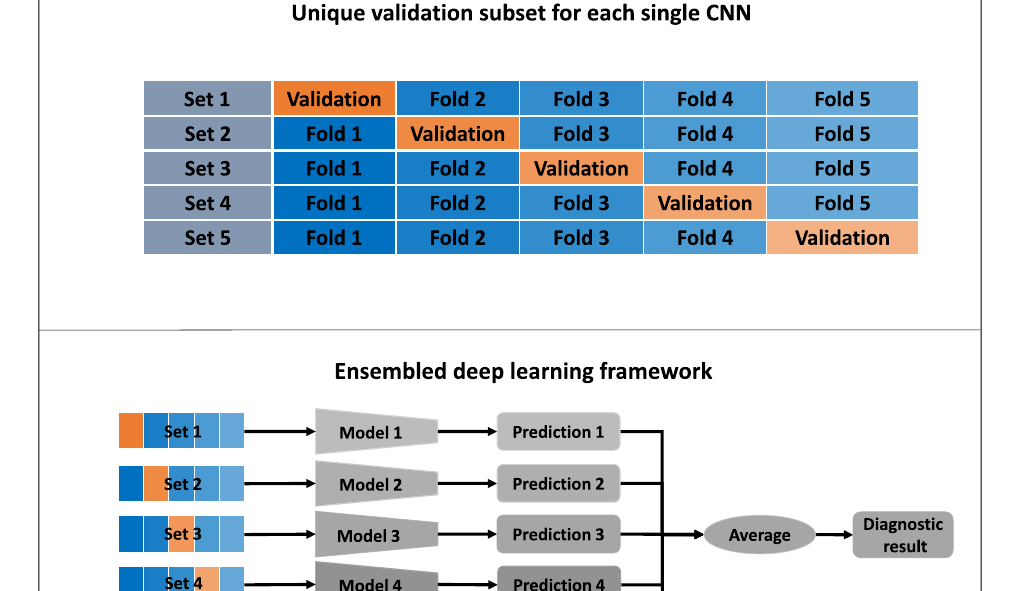
training cohort (which is divided into fi ve new subsets) to train an ensembled deep learning model, and the ensembled model was then applied to predict the category of each image in the remaining one (internal validation) subset. Such a process was repeated fi ve times, each time using a unique subset as the internal validation dataset.